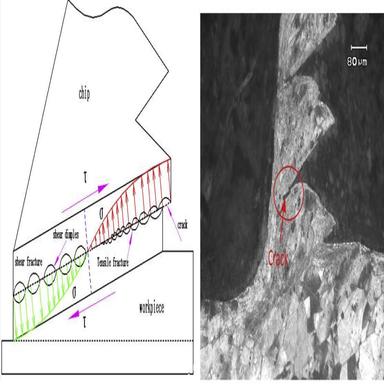
Effect of stress distribution on breakage of serrated chip.